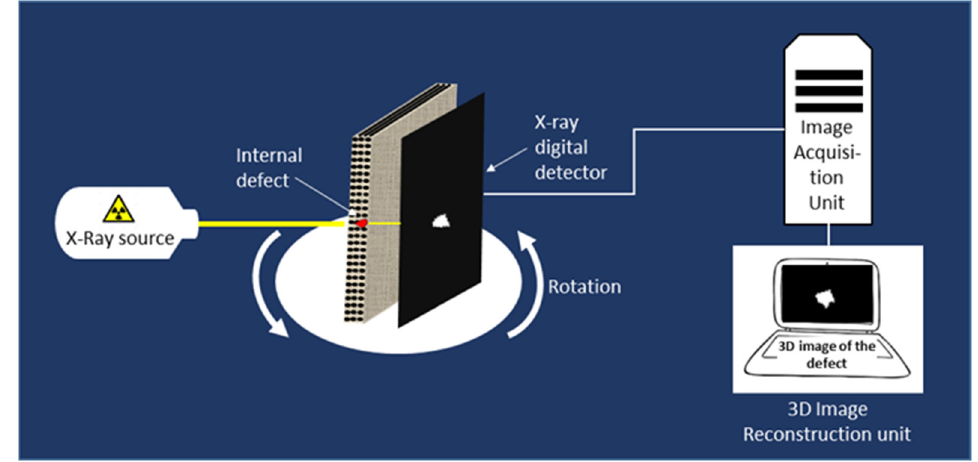
Figure 8. Principle of X-ray tomography.